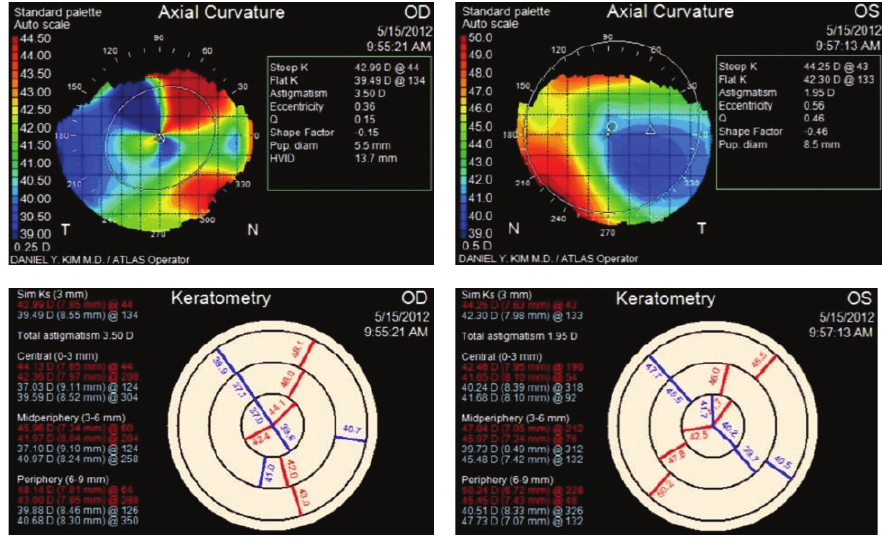
Figure 3: Axial curvature and keratometry measurements of both eyes eight months after DSEK graft placement in the right eye. Significant corneal irregularity is seen on the keratometric map in both